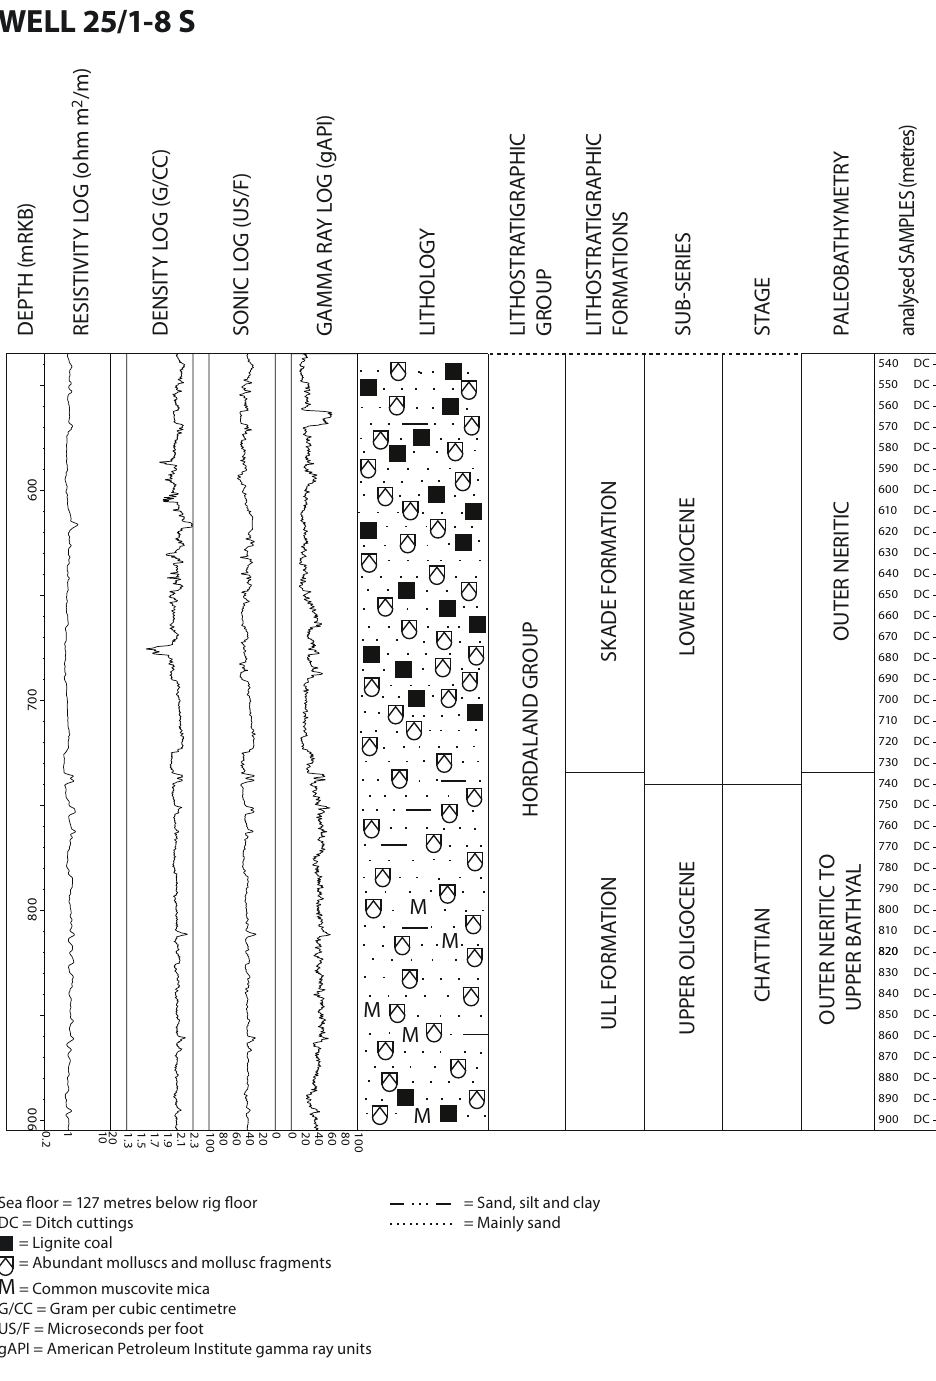
Figure 47. Well summary figure including resistivity log, density log, sonic log, gamma-ray log, lithology, litho- stratigraphic units, sub-series, stage, paleobathymetry and analysed samples for the lower part of the investigated sequence in well 25/1–8 S (Chattian to lower Miocene; modified after Eidvin et al.,